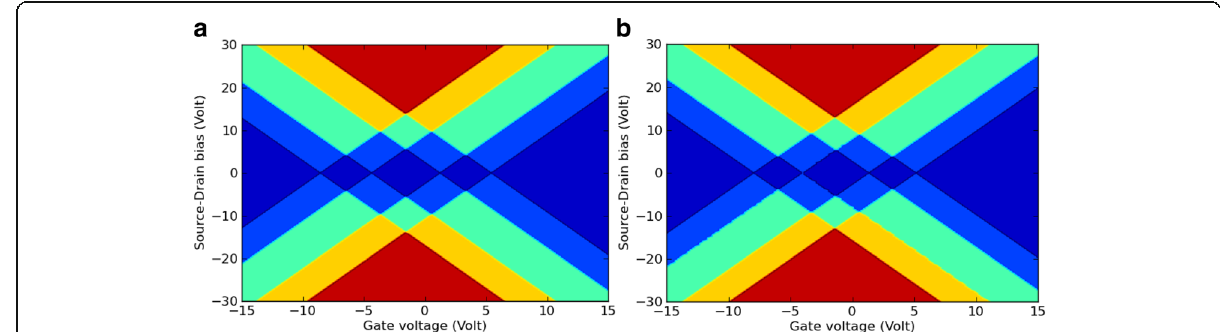
Fig. 3 The charge stability diagram for indigo ( a ) and Tyrian purple ( b ) SETs, calculated in the gas phase. The colors show the number of charge states in the bias window for a given gate voltage and exhibit the typical diamond shapes also seen in experimental Coulomb blockade measurements. The color map is blue (0), light blue (1), green (2), orange (3), and red (4)